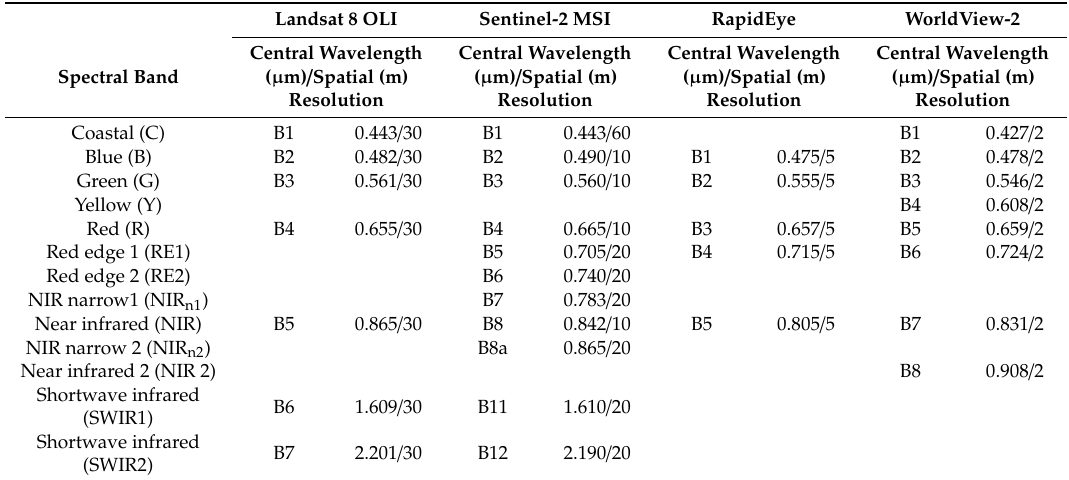
Table 1. Instrumental characteristics of the multispectral images used in the present